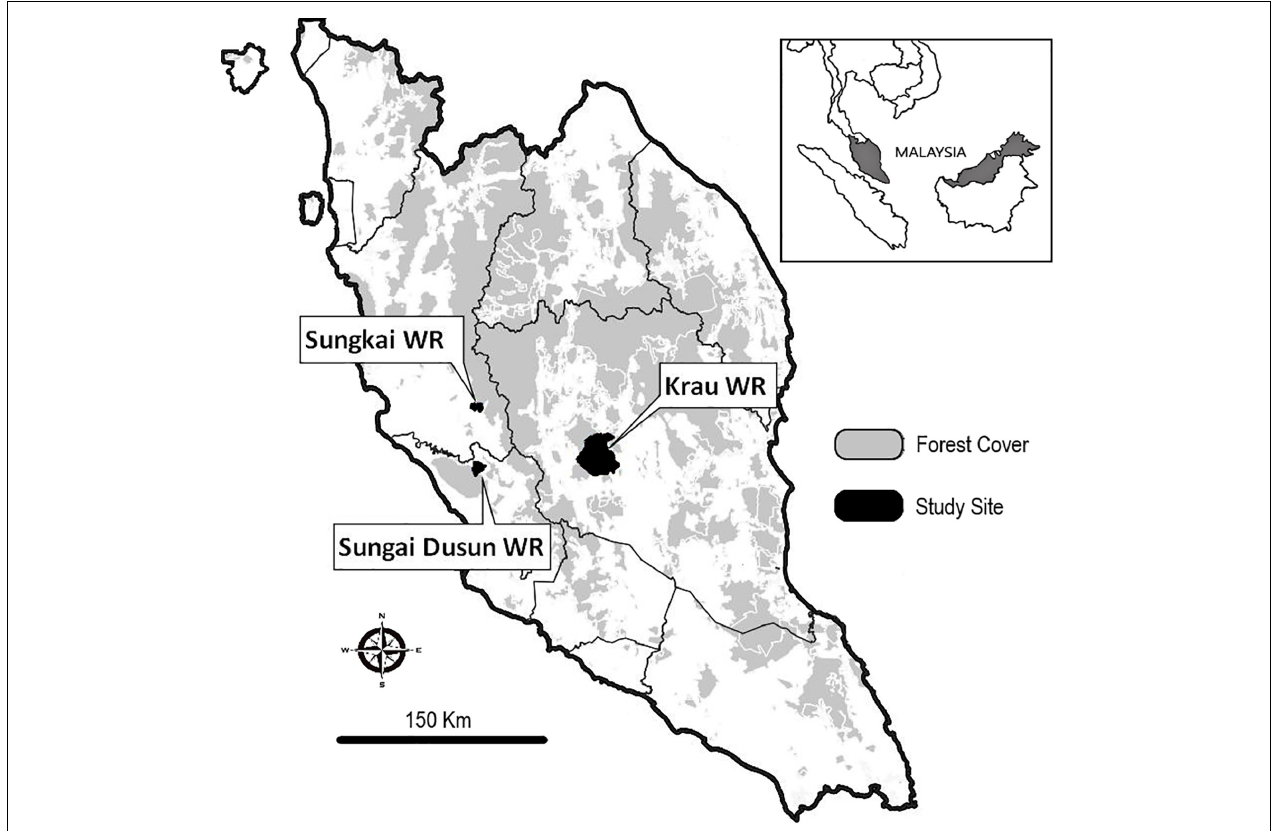
FIGURE 1 | Location of the Sungkai, Sungai Dusun, and Krau wildlife reserves (WR) in Peninsular Malaysia.